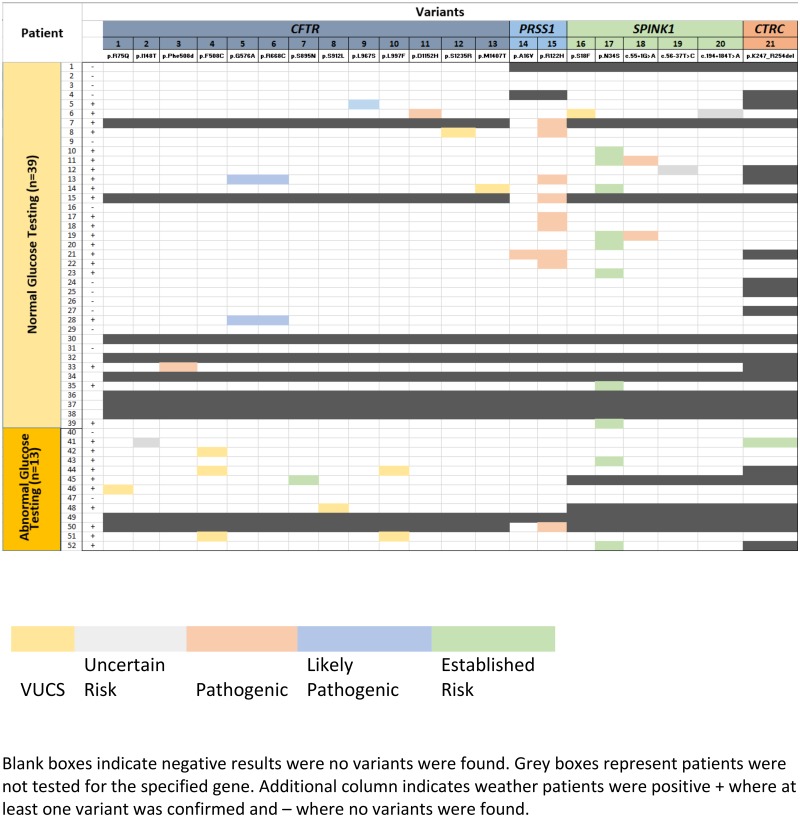
Heatmap of genetic variant distribution in the normal and the abnormal glucose testing groups.Gene variants identified after a rigorous filtering process are shown as a heat map. Specific CFTR variants are associated with abnormal glucose metabolism post-AP (p = 0.02), by Fisher Exact test. The individual patients represented as rows (n = 52). The unique variants that were confirmed in each patient are represented as columns (n = 21). Variants found in the individual patients as heterozygous are represented by the boxed highlights. The variants are classified into 5 categories each category is represented by a different color as follows.